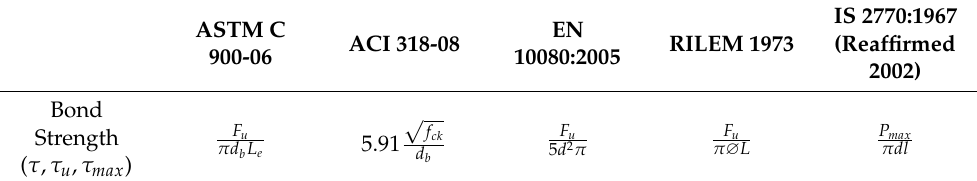
Figure 3. Various tests for analyzing bond strength in concrete. Table 1. Comparison of international codes for determining the bond strength in concrete by pull-out test [6,30 – 35].